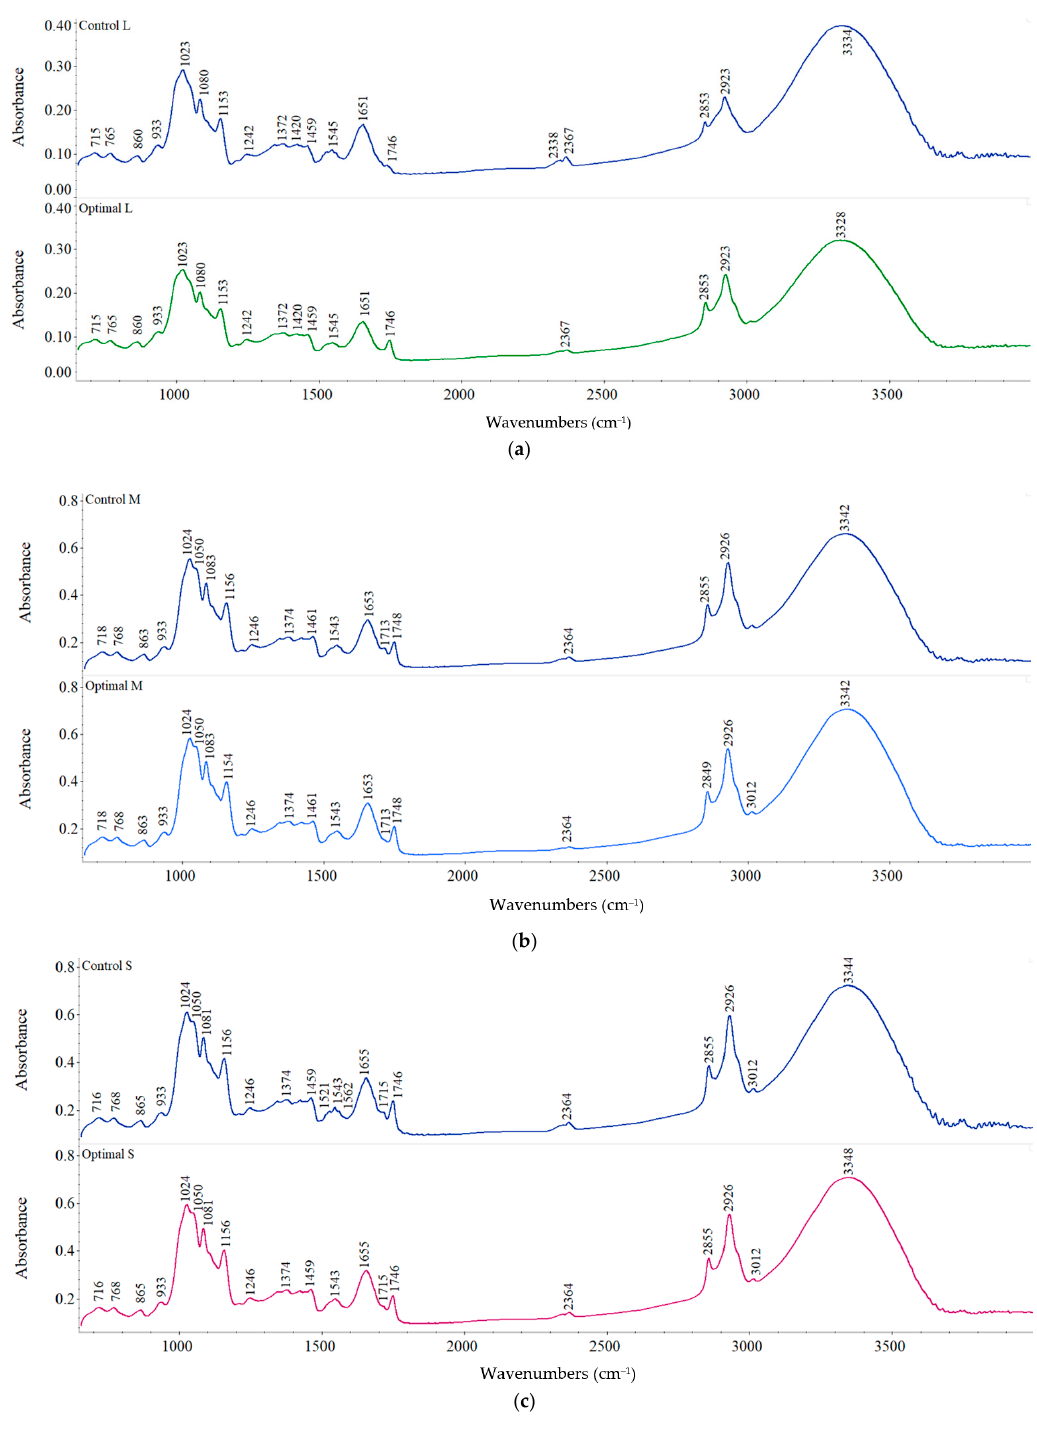
Figure 5. FT-IR spectra of control and optimal sorghum flour with: ( a ) L, ( b ) M, ( c ) S fraction. For M and S fractions, no significant changes between optimal and control samples were observed regarding peak occurrence (Figure 5b,c). Peak intensities exhibited differences among fractions, the smallest values being obtained for L fraction. The band appeared at around 3328–3342 cm − 1 suggesting the O–H bond stretching from starch and protein–starch interaction and also from water molecules, alcohol, phenolic compounds, or carboxylic acid, while the modification in peak intensity indicates the degree of formation of hydrogen bonds (inter- and intramolecular) [54]. The lower intensities of peaks at 3328–3342 cm − 1 for all the optimal samples compared to the corresponding controls could lead to a rise in dehydroxylation reactions upon dry heat treatment [14]. The modification of this band position towards a lower peak intensity suggests an enhancement in the bond strength caused by the interaction within starch molecules and starch with other compounds [55]. The bands observed at about 1156, 1081, and 865 cm − 1 for all the studied samples suggest the presence of alcohol (C–O), anhydrides (C=O), and alkane (C–H) groups, respectively [54]. The modification in the intensities of these bands in the optimal samples could be related to the deformation of angular C–H bond, the vibration of—1–4 glycosidic bonds (C–O–C) and C–O linkages in the esters (developed between the –COOH and O–H group of protein and starch, respectively), and could have led to the appearance of new functional groups [14,54].